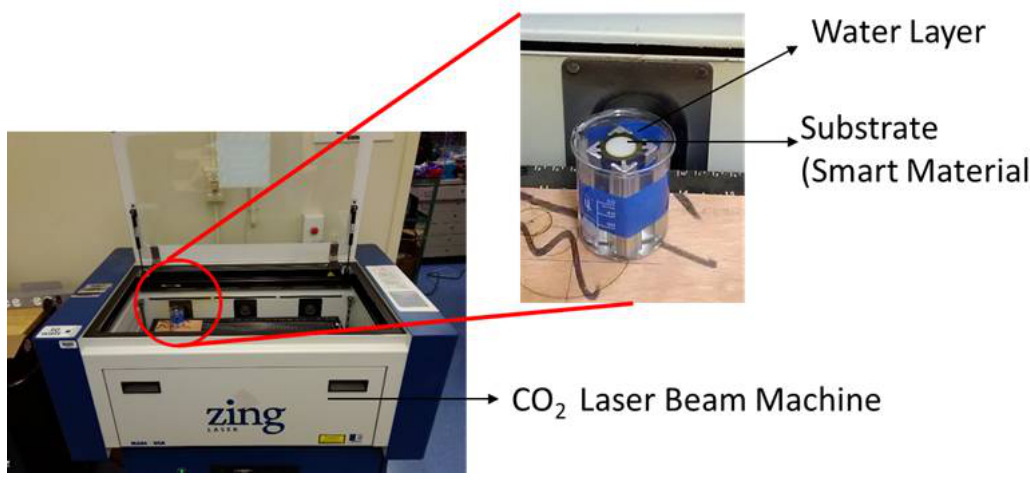
Figure 4. Experimental setup of LA-LBMM process for machining smart ceramic materials. Table 1. Experimental conditions used for micromachining smart ceramic materials using LA-LBMM process.